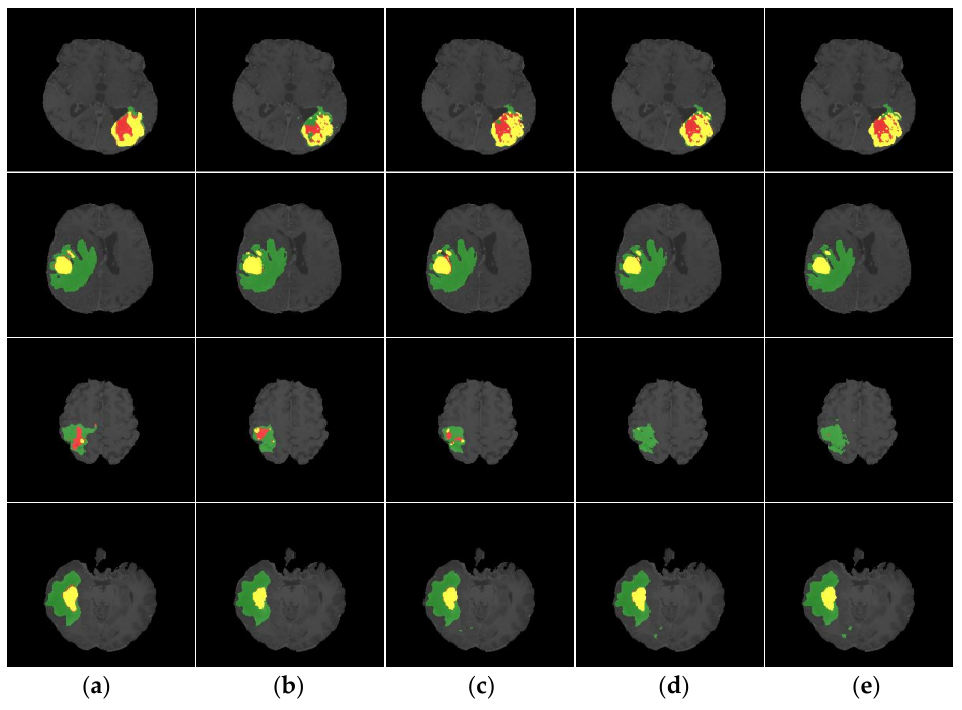
Figure 5. Comparison of segmentation results of four brain tumor samples, in which red, yellow, and green indicate necrotic area, enhanced tumor area, and edema area, respectively. ( a ) FCN; ( b ) SegNet; ( c ) At-Unet; ( d ) LSW-Net (Ours); ( e ) Ground truth.